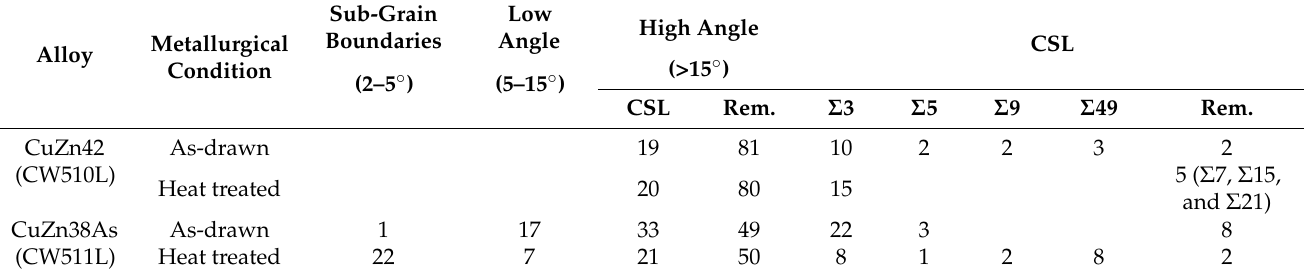
Table 4. Results of EBSD scans, distribution of grain boundaries’ angles